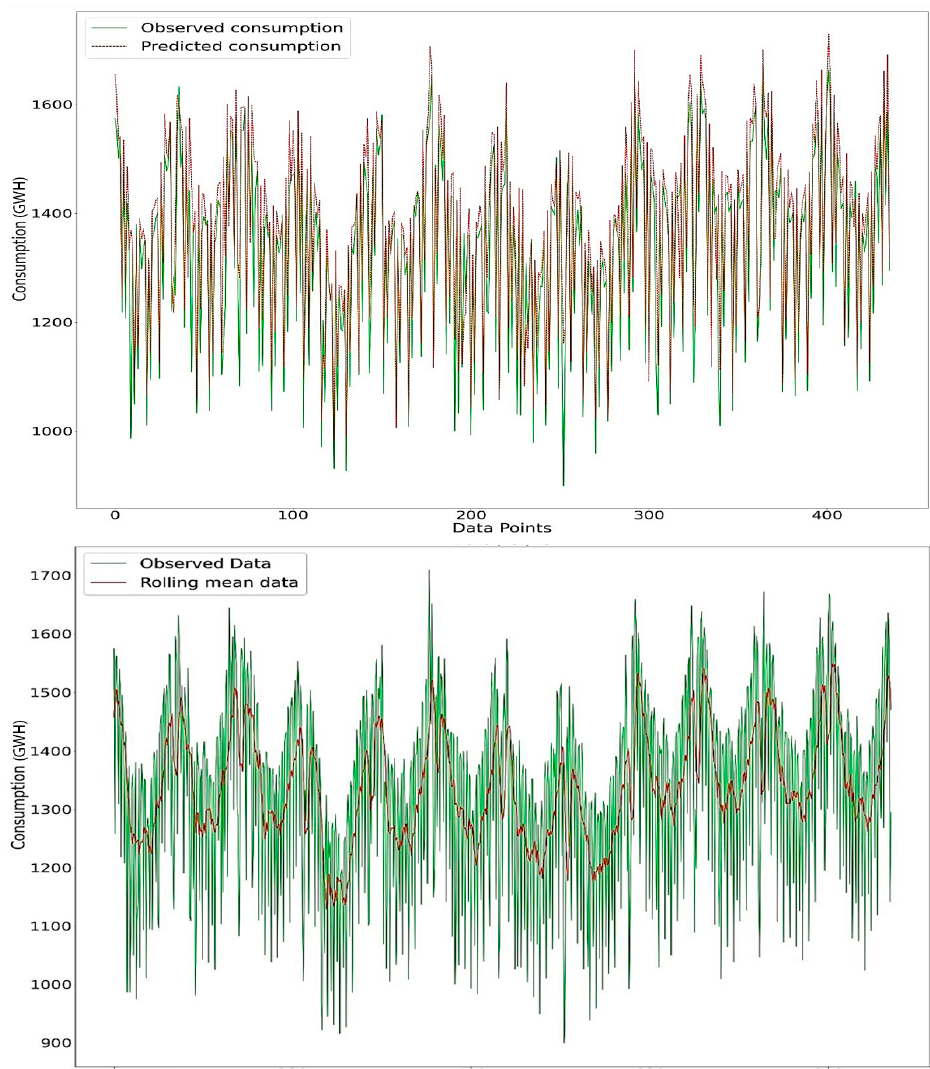
Figure 5. Rolling mean of the predicted consumption and the observed